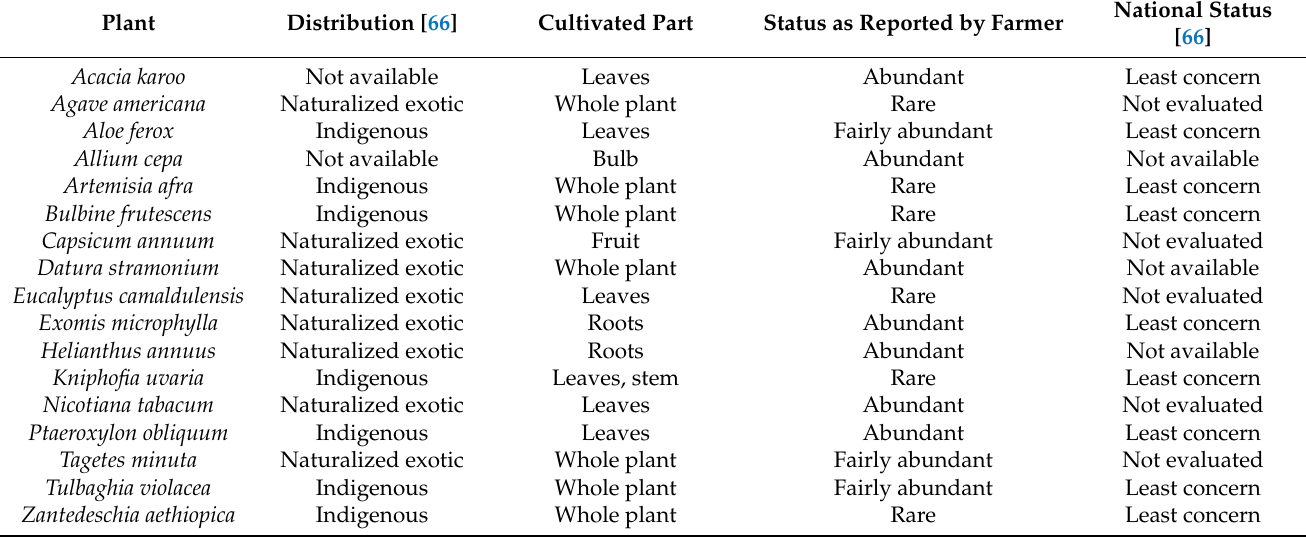
Table 3. Conservation status and availability of reported plant species used by subsistence farmers in mitigating cabbage and spinach diseases in OR Tambo Municipality, South